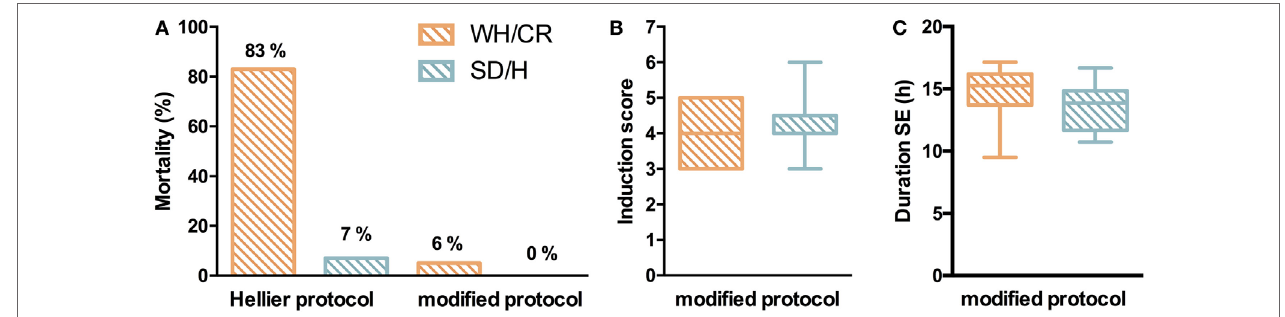
FigUre 2 | Status epilepticus (SE) in KASE WH/CR and KASE SD/H rats. (a) Mortality rates for both rat strains during SE induction. (B) Severity of the SE between the two strains during the modified protocol. Hellier protocol: WH/CR n = 6 and SD/H n = 15; modified protocol: WH/CR n = 51 and SD/H n = 25 (a,B) . (c) Duration of SE in WH/CR ( n = 10) and SD/H ( n = 8) during the modified protocol. WH/CR, Wistar Han/Charles River; SD/H, Sprague-Dawley/Harlan; KASE, kainic acid-induced status epilepticus